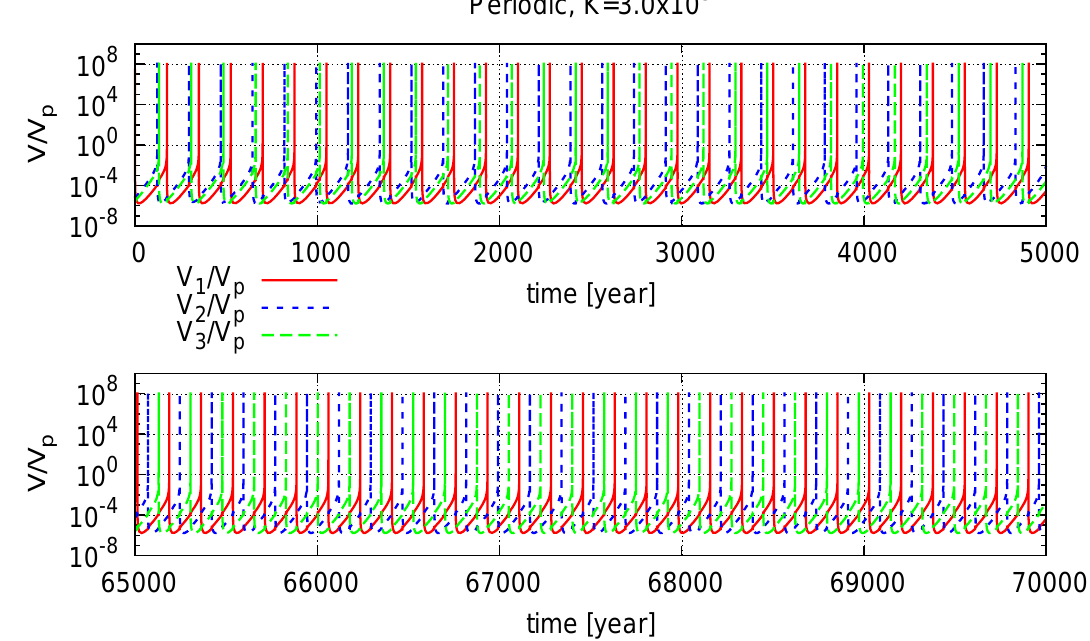
Fig. 11. The time evolution of V/V p for three identical oscillators with a periodic coupling in a logarithmic scale. Red, blue, and green curves correspond to oscillators 1, 2, and 3, respectively. The variation from 5000 to 65000yr is not shown. The parameters are B = 2 . 20 × 10 5 Nm − 2 for all oscillators, and k 12 = k 23 = k 31 = 3 × 10 3 Nm − 3 (periodic one-dimensional coupling). The three oscillators synchronize π, − 2 π) . This synchronization corresponds to a stable spiral in Fig. 13. at the phase differences (ψ 1 ,ψ 3 ) ’ ( 2 3 3